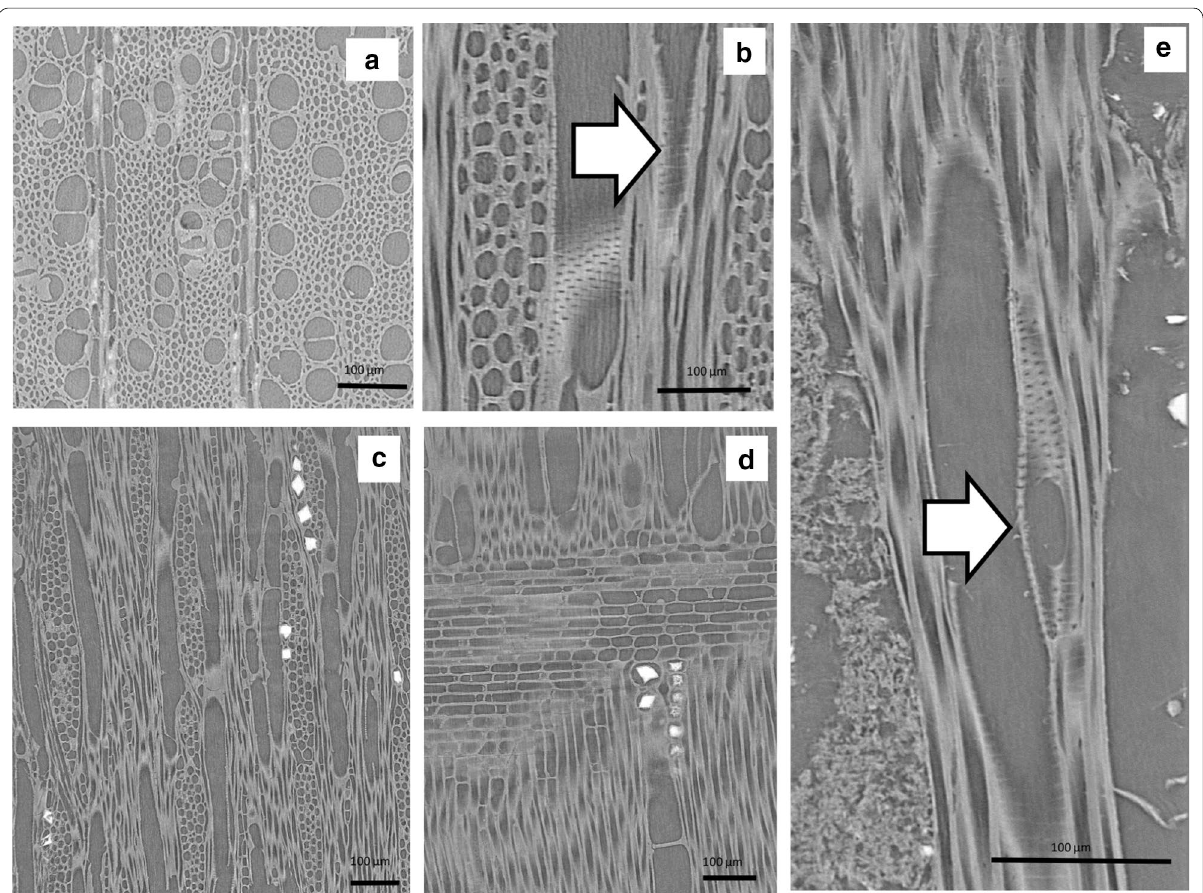
Fig. 4 Pseudo-sections constructed from the SRX-ray μCT dataset from SPring-8 for male deity 8 (f in Table 1). a cross-section, b , c , e tangential section, d: radial section. b and e are magnified images of tangential sections. The sample is typical diffuse porous wood ( a ) with a simple perforation plate ( e ). In the radial and tangential sections, widely spaced spiral thickenings (arrowhead in b ) are observed. In the tangential section, an alternate arrangement of intervessel pitting is clearly observed ( b ) and prismatic crystals exist in chambered AP cells ( d